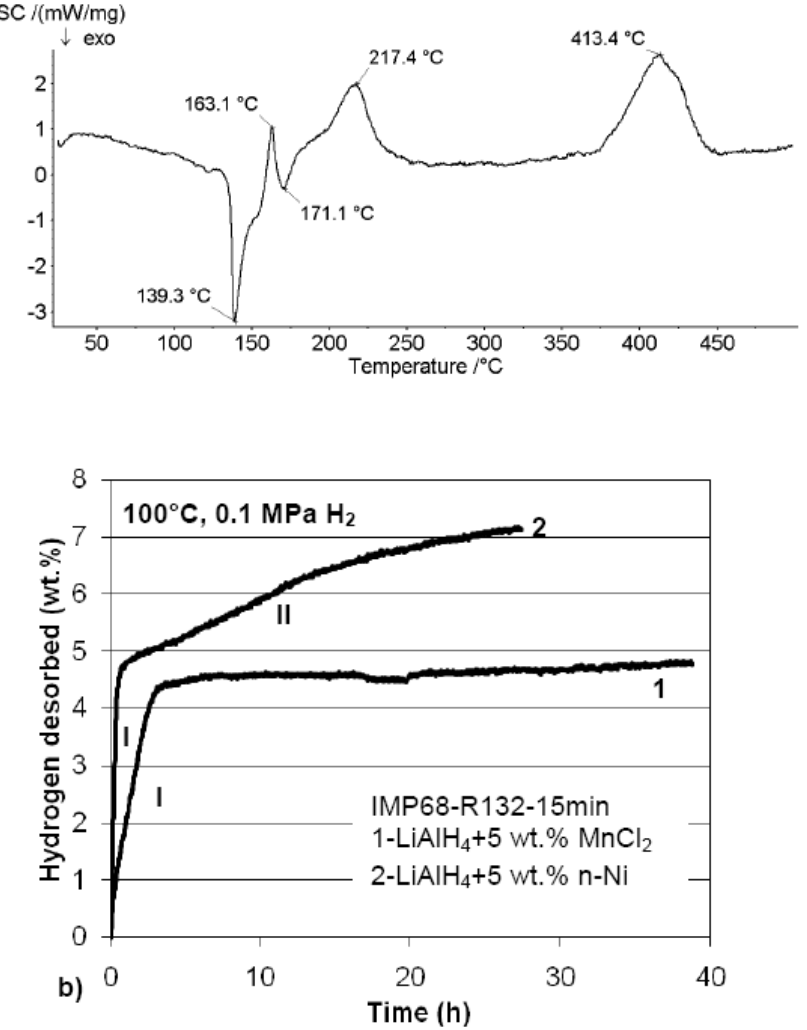
Figure 18. (a) DSC curve for LiAlH + 5 wt.% MnCl ball milled under high energy 4 2 impact mode. (b) Comparison of volumetric desorption curves at 100 °C under 0.1 MPa H 2 for catalyzed LiAlH ball milled under high energy impact mode. 1 - LiAlH + 5 wt.% 4 4 MnCl and 2 - LiAlH + 5wt.% n-Ni. R - ball-to-powder weight ratio; IMP68 - high energy 2 4 impact mode with 2 magnets in a magneto-mill. Adapted from